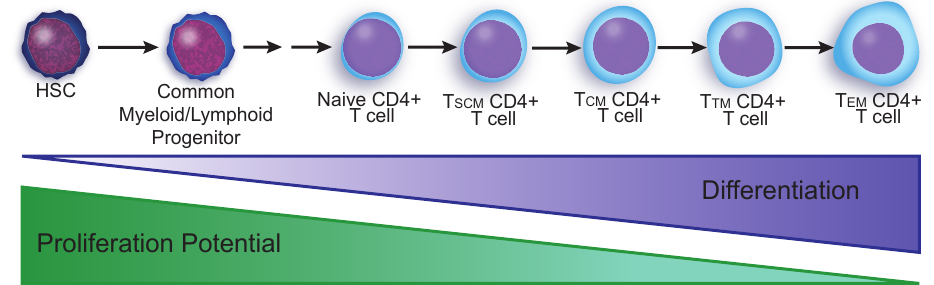
Figure 2. Di ff erentiation and proliferative potential of the latent reservoir. Hematopoietic stem cells (HSC) are multipotent and di ff erentiate into both common myeloid and lymphoid progenitors. Through several more steps of di ff erentiation, naïve CD4 + T cells emerge from the lymphoid lineage as the least di ff erentiated of the terminally di ff erentiated T cell subsets. T cells undergo successive rounds of activation and di ff erentiation through memory stem cells (T SCM ), central memory (T CM ), transitional memory (T TM ), to e ff ector memory (T EM